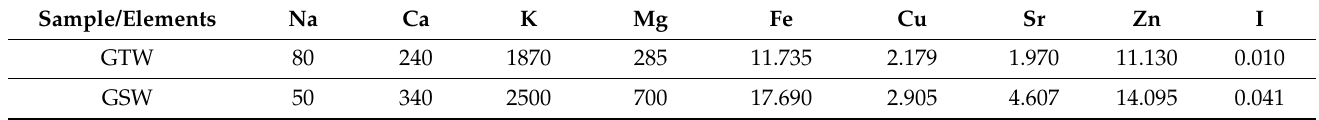
Table 2. Macro-micro elements of GTW and GSW samples expressed in